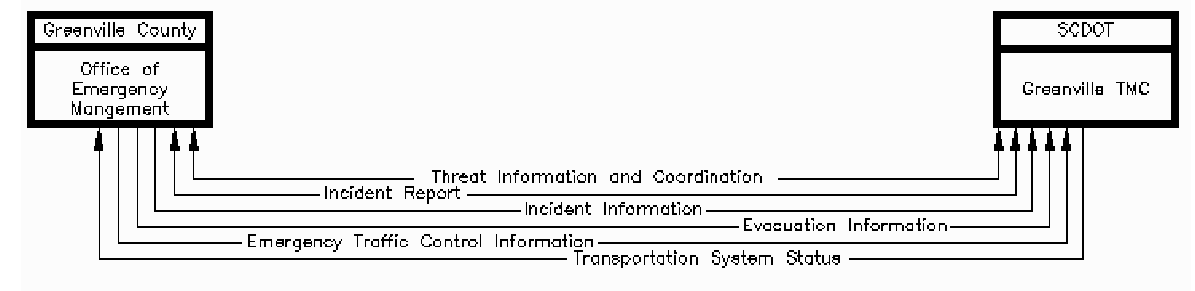
Figure 2. Information flow